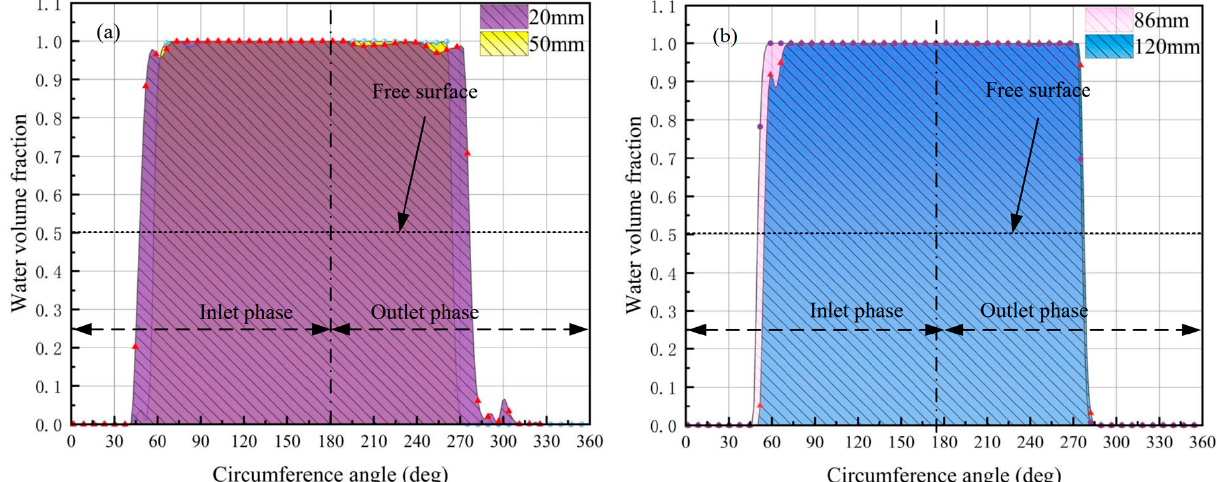
Figure 7. Water volume fractions at the wheel’s outer circumference. ( a ) Between the clearance of 20 mm and 50 mm; ( b ) Between the clearance of 86 mm and 120 mm.